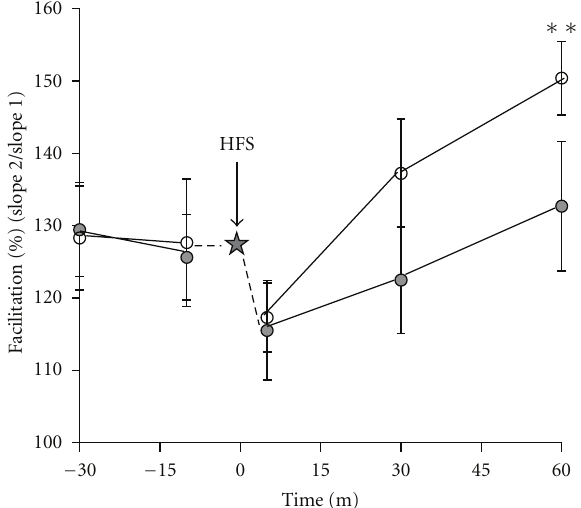
Figure 5: Copper gradually enhanced the PPR after LTP in the CA1 region. Paired-pulse tests were done at intervals before and after the HFS tetanus (star). Prior to the tetanus, the PPR was not signif- icantly di ff erent between control slices (filled circles) and copper- treated slices (open circles). Five minutes after the HFS, there was a decrease in the PPR. The di ff erence in the percent facilitation became statistically significant 60 minutes after the tetanus, at which point the average PPR of the copper group was 150 . 4 ± 5 . 1% as compared to 132 . 7 ± 8 . 9% in the control group ( P = 0 . 007, n =